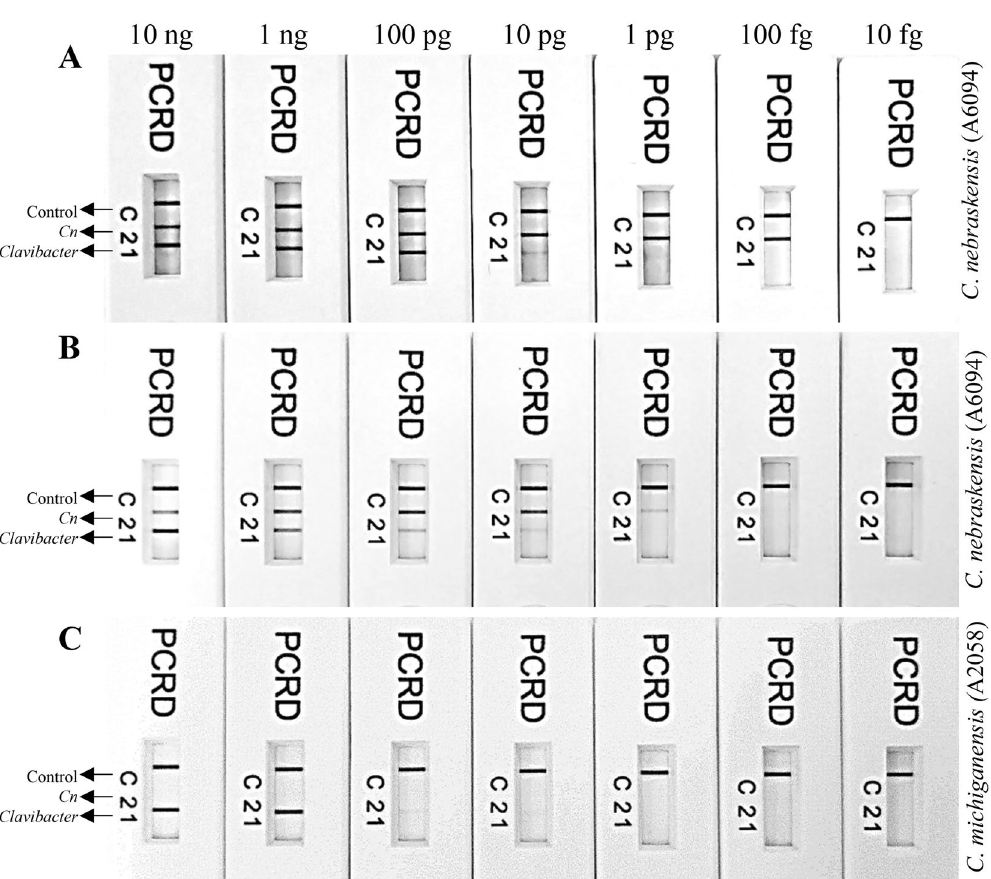
Figure 4. Limit of detection determination of multiplex RPA assays developed for specific detection of genus Clavibacter in general and C. nebraskensis . Line 1: detects Clavibacter species/subspecies strains; line 2 detects C. nebraskensis strains, and; line C is a control line. The primer/probe sets for genus Clavibacter and C. nebraskensis are labeled with Biotin/DIG and Biotin/FAM, respectively. A tenfold genomic DNA serial dilution (10 ng–10 fg) was used to perform the sensitivity assays. ( A ) Limit of detection determination using pure C. nebraskensis (A6094) DNA; detected until 100 fg and 10 pg using Clavibacter and C. nebraskensis specific primers/probe set, respectively. ( B ) Spiked multiplex test performed by adding 1 µL of corn plant sap in tenfold serially diluted C. nebraskensis (A6094) genomic DNA; detected until 1000 fg and 10 pg using Clavibacter and C. nebraskensis specific primers/probe set, respectively. ( C ) Detection using tenfold serially diluted C. michiganensis (A2058) purified genomic DNA; detected until 10 pg by Clavibacter genus-specific primers/probe—no detection with C. nebraskensis specific primers/probe